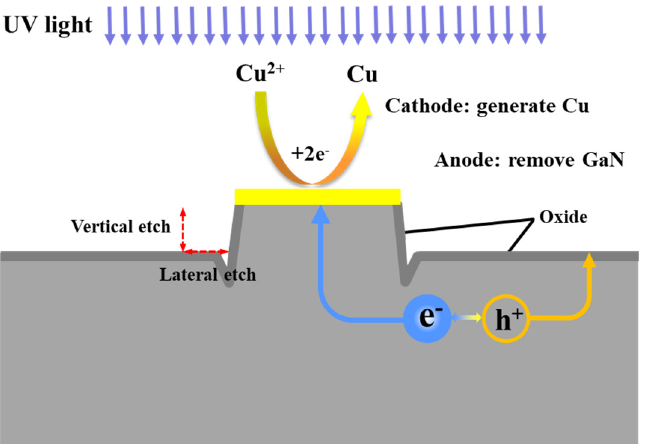
Figure 6. Illustration of the metal-assisted chemical etching mechanism of